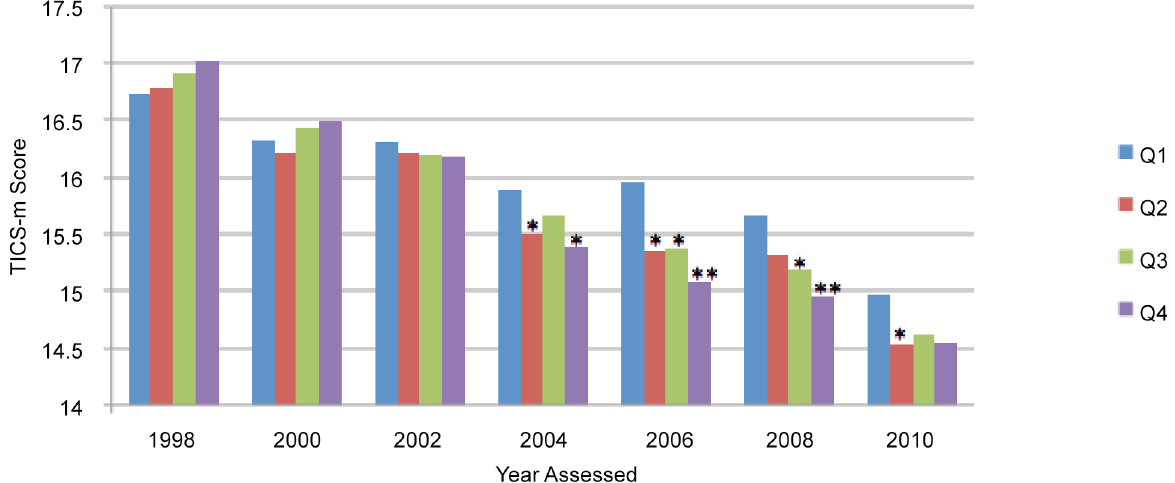
Fig 1. Marginal TICS-m scores between 1998 and 2010 corresponding to residence in quartiles of 1990 MSA-level income inequality, Health and Retirement Study. Adjusted for baseline age, gender, race/ethnicity, education, net wealth, self-reported medical diagnoses of diabetes, hypertension, heart disease, and stroke, body mass index, and the 1995/1996 TICS score; and the percentage Black and median household income at the MSA level. Quartile 1 (Q1) for the Gini coefficient (reference category) corresponds to the quartile of US MSAs with the lowest Gini coefficients (lowest level of income inequality), based on 304 MSAs with available Gini coefficient data. * P (cid:1) .05; ** P (cid:1) .01 for comparison of marginal TICS-m scores for those living in the respective higher income inequality quartile (Q2, Q3, or Q4) to scores for those in